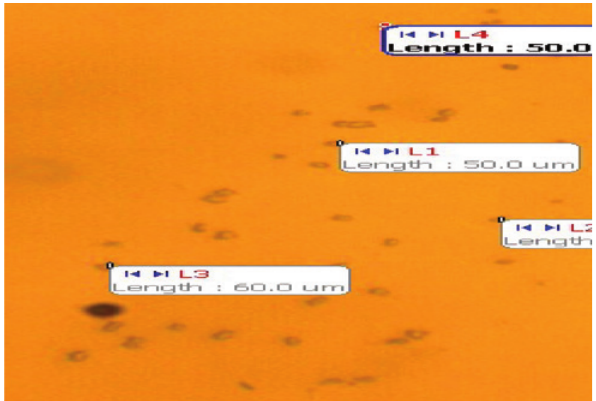
Figure 1: Particle size distribution of neem broth.